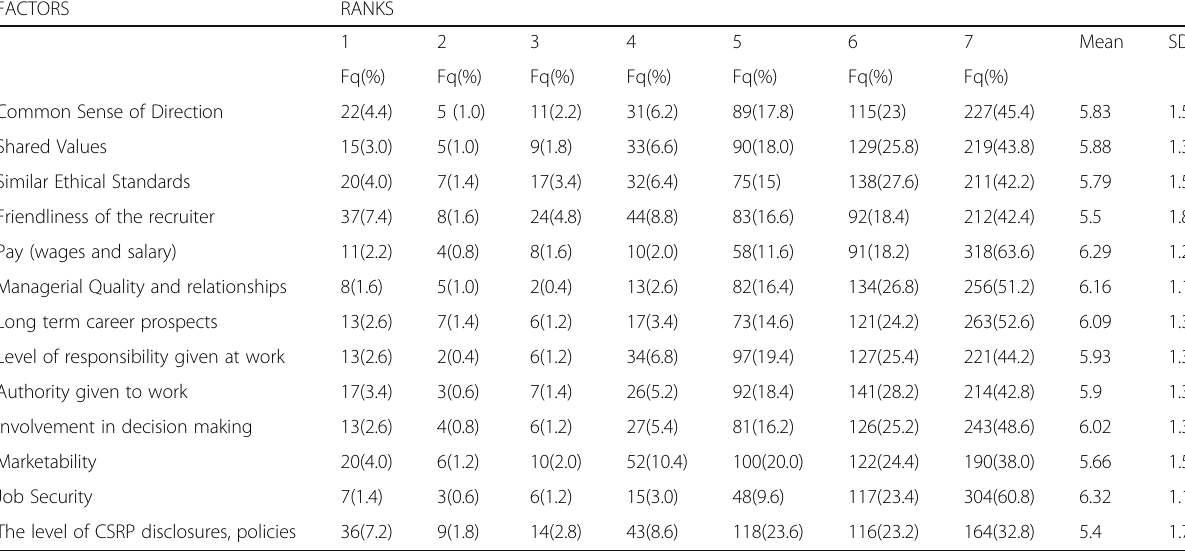
Table 3 Elements of Organisational